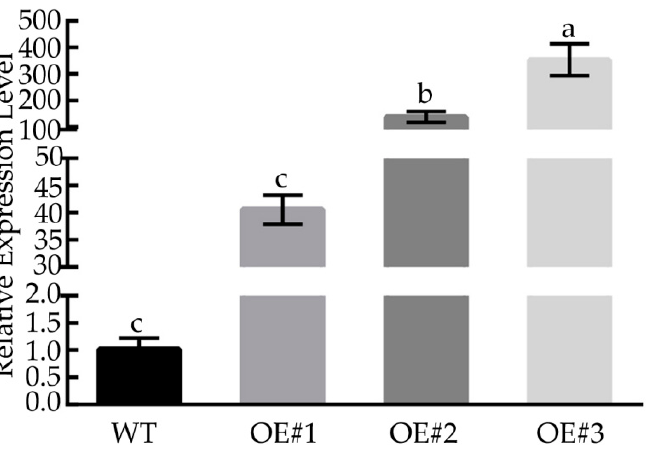
Figure 9. Subcellular localization analysis of BcLEA73 in Wucai.